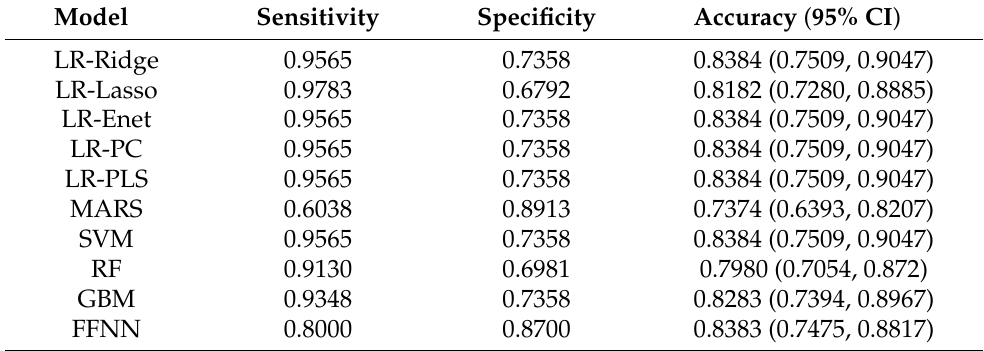
Table 9. Comparing predictive performance of the 10 models applied to the heart disease data.